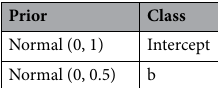
Prior Class Normal (0, 1) Intercept Normal (0, 0.5) Table 1. Weakly informative priors. b = population-level or fixed effects.